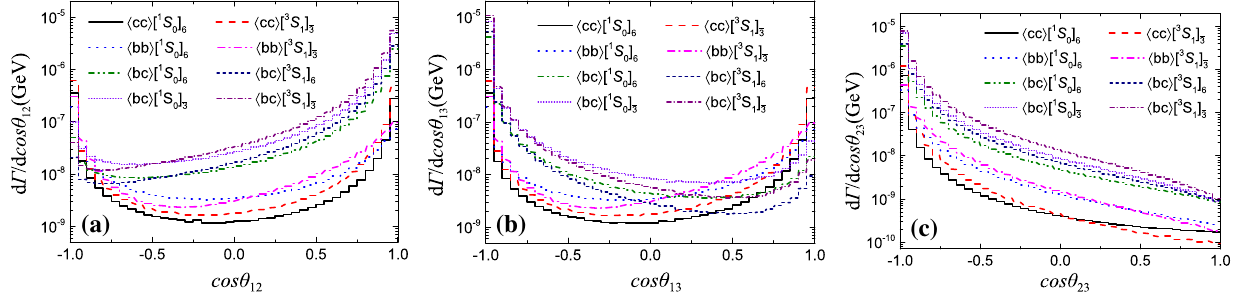
Fig. 3 The angular differential decay widths d (cid:6)/ d cos θ 12 ( a ), d (cid:6)/ d cos θ 13 ( b ) and d (cid:6)/ dcos θ 23 ( c ) for the process H 0 → (cid:2) QQ (cid:3) + ¯ Q (cid:3) + ¯ Q . Eight lines represent the possible spin and color configurations, i.e., (cid:4) cc (cid:5)[ 1 S 0 ] 6 , (cid:4) cc (cid:5)[ 3 S 1 ] ¯